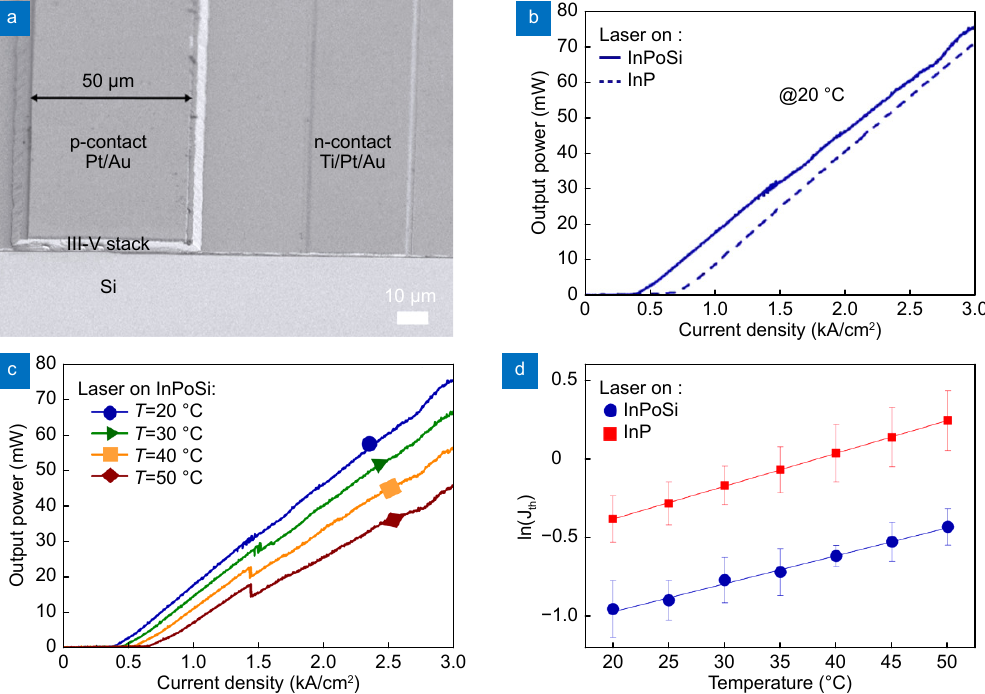
Fig. 11 | ( a ) SEM image of the fabricated FP laser on InP-on-Si substrate. ( b ) J-L characteristics in pulse injection mode at 20 °C: laser on bon- ded substrate (solid line) and the laser on InP (dash line). ( c ) J-L characteristics in pulse injection mode measured at different temperatures for the laser on bonded substrate. ( d ) Threshold current density evolution against temperature for the laser on bonded substrate (blue) and on InP (red). Figure repoduced with permisson from ref. 32 ,